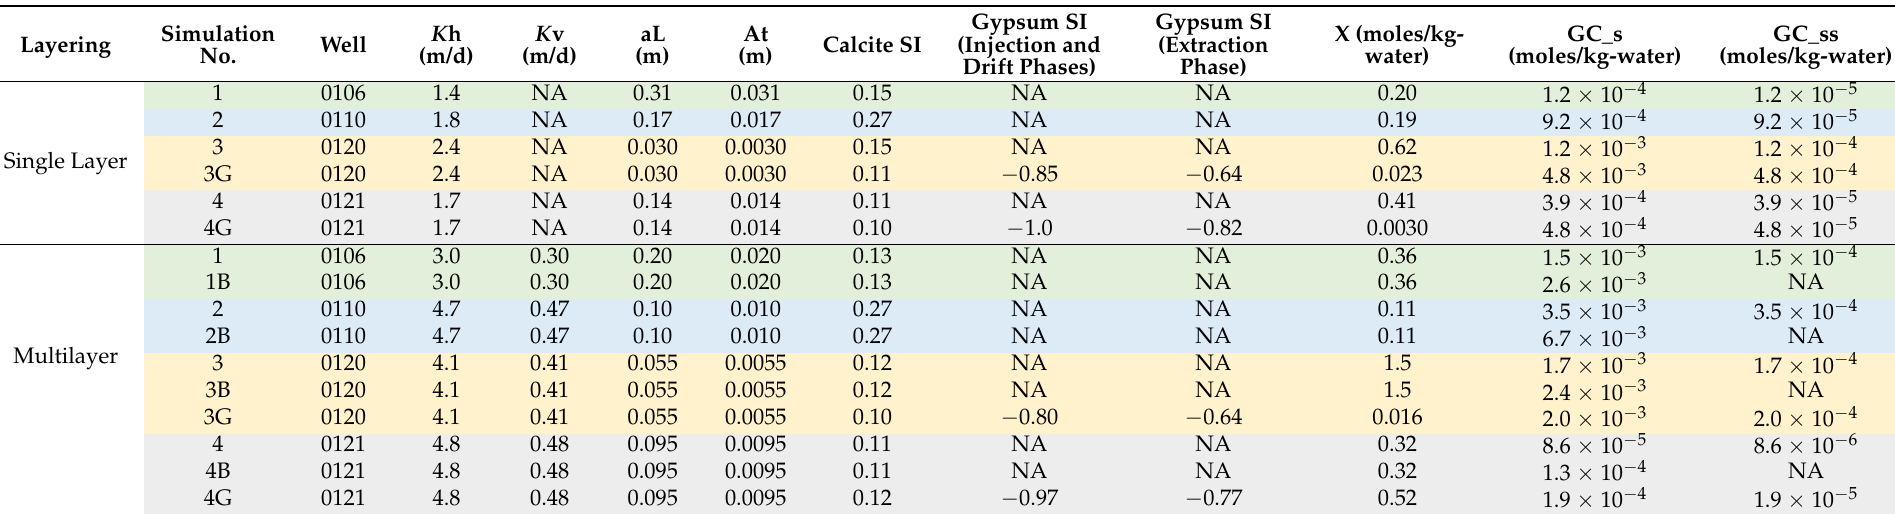
Table 4. Estimated Parameters for Each Push–Pull Tracer Testing Well Using Single-Layer and Multilayer Modeling Approaches. Simulation Layering